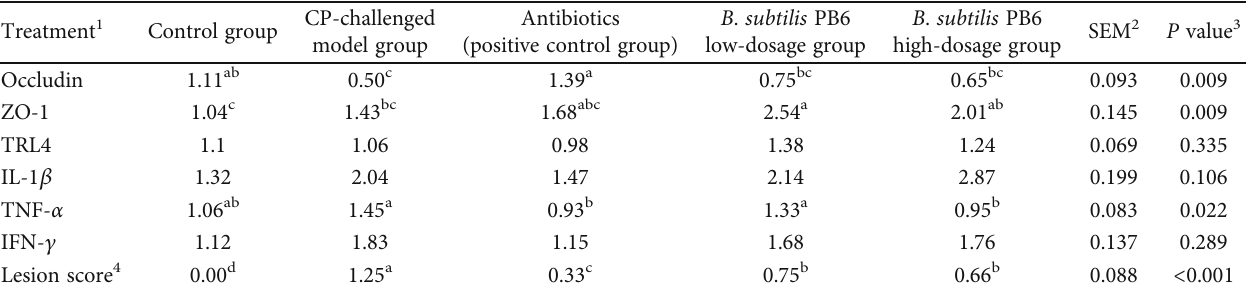
Table 4: Intestinal lesion score and relative mRNA expression of intestinal tight junction proteins and proin fl ammatory cytokines in